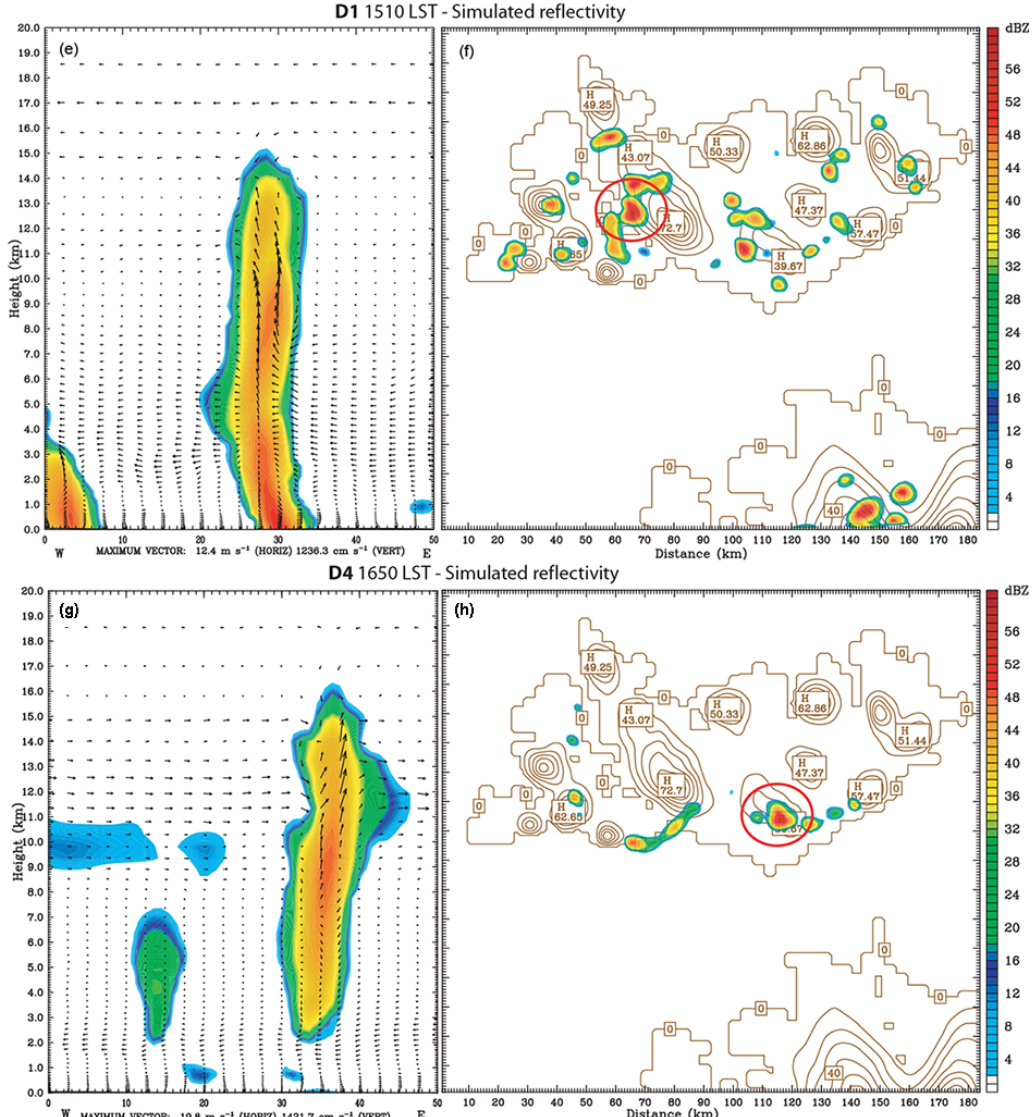
Figure 5. Sections at the maximum development of the Hector events N27 (double-cell), D1 and D4. (a, c, e) Simulated vertical radar reflectivity (dBZ; filled color) and vertical wind; the section is taken longitudinally along the red circle reported in the right panel. (b, d, f) Horizontal radar reflectivity (dBZ; filled color) and topography